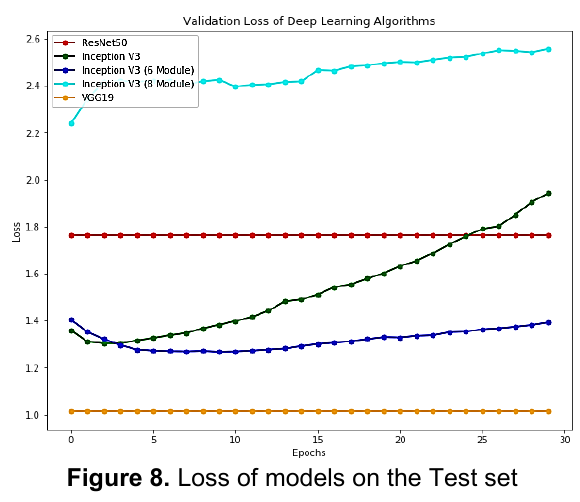
Figure 8. Loss of models on the Test set